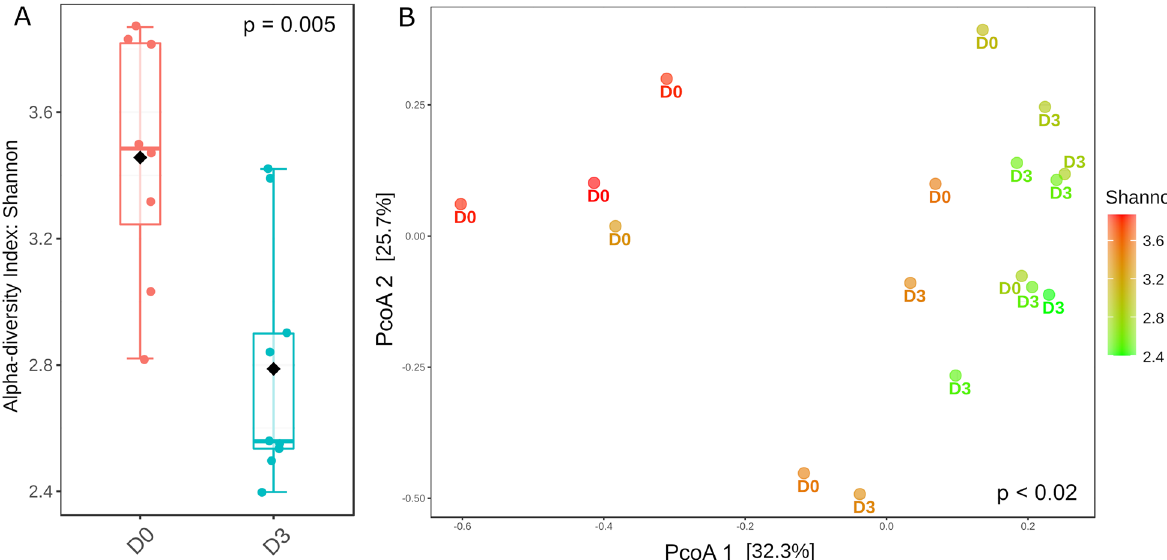
Fig. 4 Alpha ( A ) and beta ( B ) diversity measures of scenarios D0 and D3. Shannon’s Diversity Index for D0 and D3 is shown in panel A (Kruskal– Wallis statistic: 64; p 0.005). Bray–Curtis distance matrix (ANOSIM’s R: 0.28; p < 0.002) for scenarios D0 and D3 is illustrated in panel ( B ). Alpha = diversity is also shown in the ordination plot through a color gradient from green (low value) to red (high